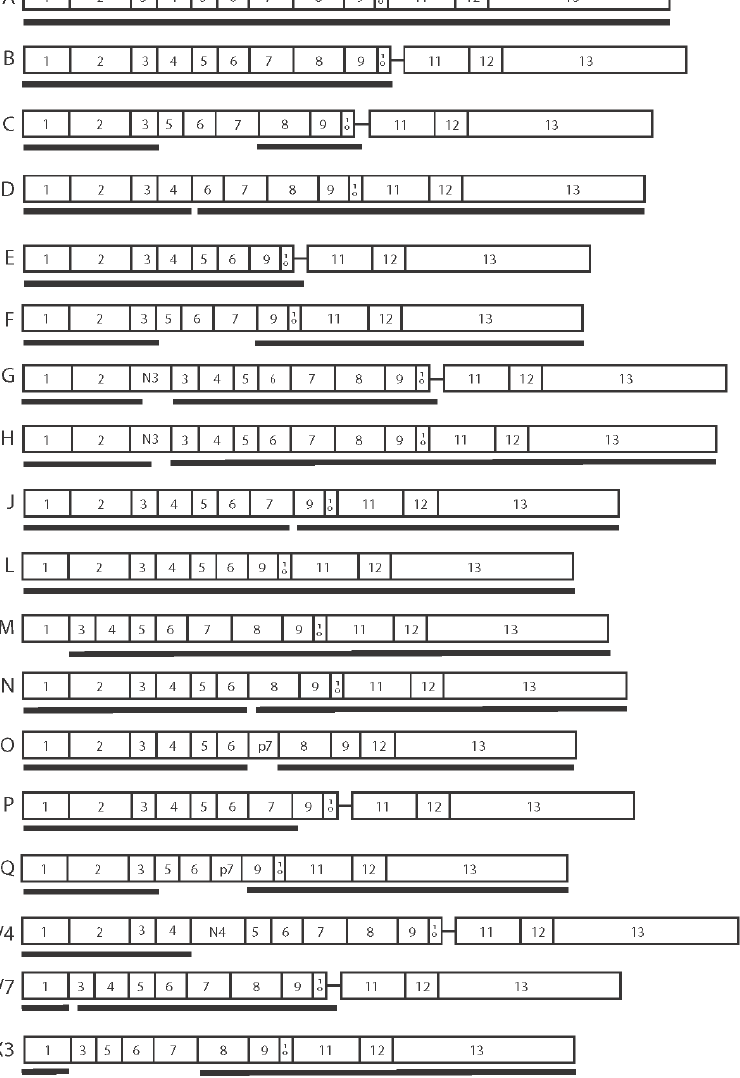
Figure 3. P2RX7 mRNA isoforms and predicted proteins. Diagrammatic representation of the exons (open numbered boxes) comprising each transcript (mRNA variant names are listed on the left of each transcript). The thin line joining exon 10 to exon 11 represents the retained intron 10. N3 and N4 are alternative exons; p7 indicates that part of the sequence for exon 7 is missing. Thick black lines represent the proteins that could be translated beginning at the primary start codon in exon 1 or at an alternative site.